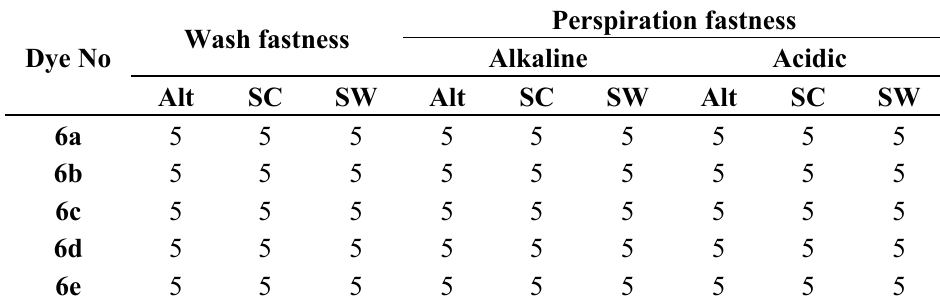
Table 4. Fastness properties of monoazo disperse dyes on polyester fabrics using microwave dyeing